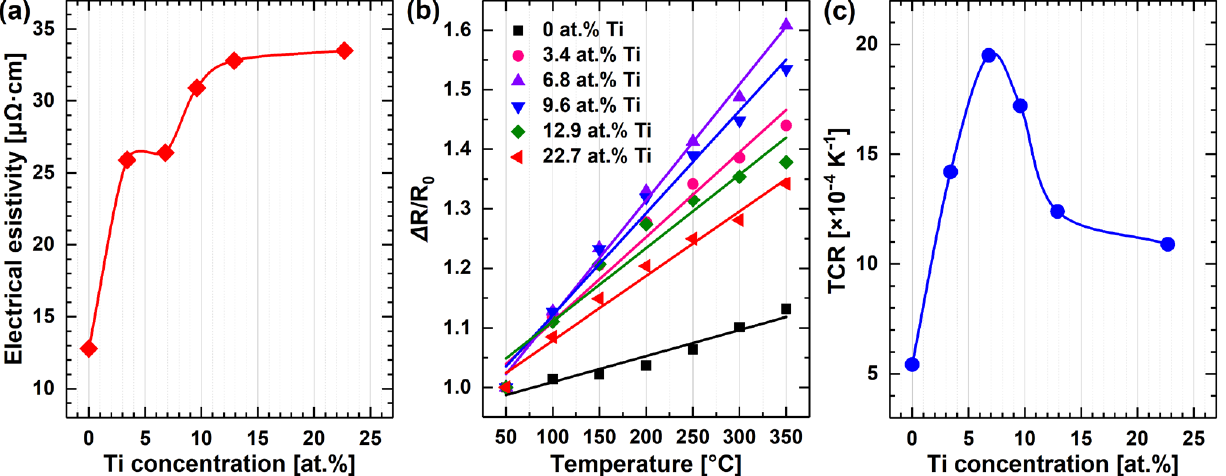
Figure 5. ( a ) Room-temperature electrical resistivity, ( b ) thermal resistance curves, and ( c ) TCR values of the WTi alloy films as a function of Ti concentrations.